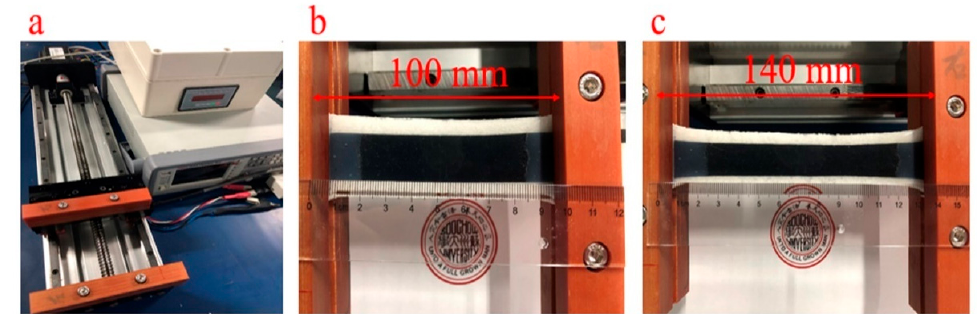
Figure A1. The images of the PDMS sponge with different mass fraction of CAM. ( a ) m PDMS :m CAM = 1:3, ( b ) m PDMS :m CAM = 1:5, ( c ) m PDMS :m CAM = 1:7, ( d ) m PDMS :m CAM = 1:9, ( e ) the images of four PDMS sponges. Figure A2b is the machine which was used in durability test. Figure A3c,d demon- strates the procedure.